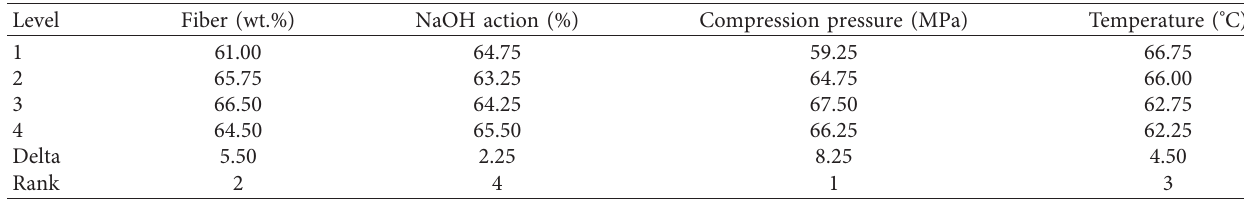
Table 9: Response table for means (shore D hardness).